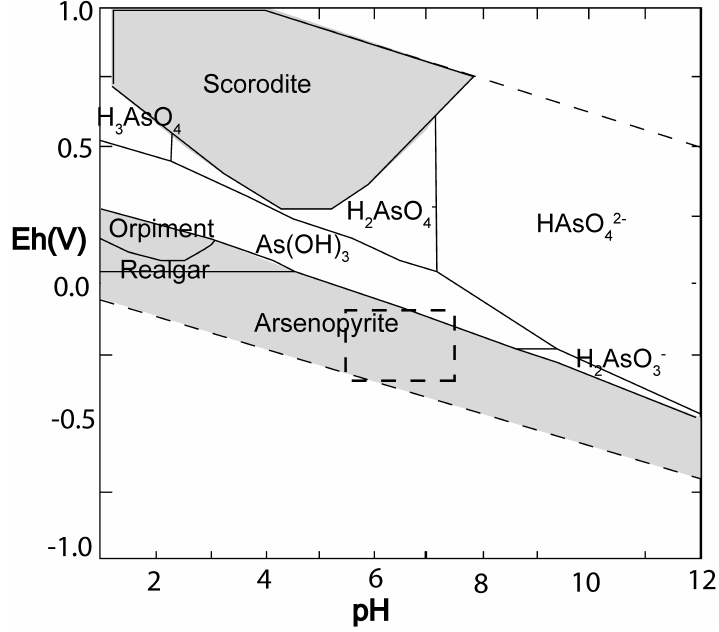
Figure 1. Eh-pH diagram for As-Fe-S-O-H at 25 ◦ C and 1 atm pressure. Predominant arsenic species predicted for the chemistry of the BCR pore water at: total arsenic, 0.44 mM; total sulphur, 7.00 mM; total iron, 0.23 mM. Solid species and stable (equilibrium) phases are indicated with the dark field. Diagram produced from Spana software